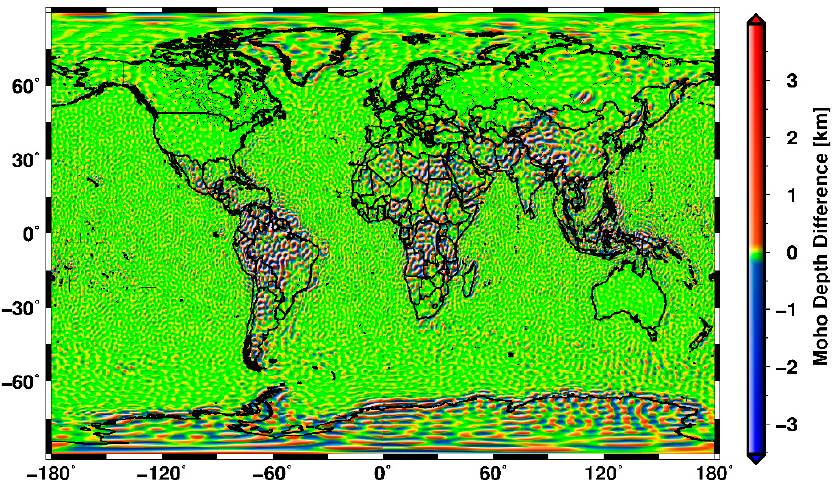
Figure A1. The differences between the VMM Moho depth estimates from the EGM2008 and EIGEN-6C4 gravitational models. Unit: km. Table A1. The Moho depth differences obtained by solving the VMM problem by using the EGM2008 and EIGEN-6C4 gravitational models. Unit: Percentage (%).